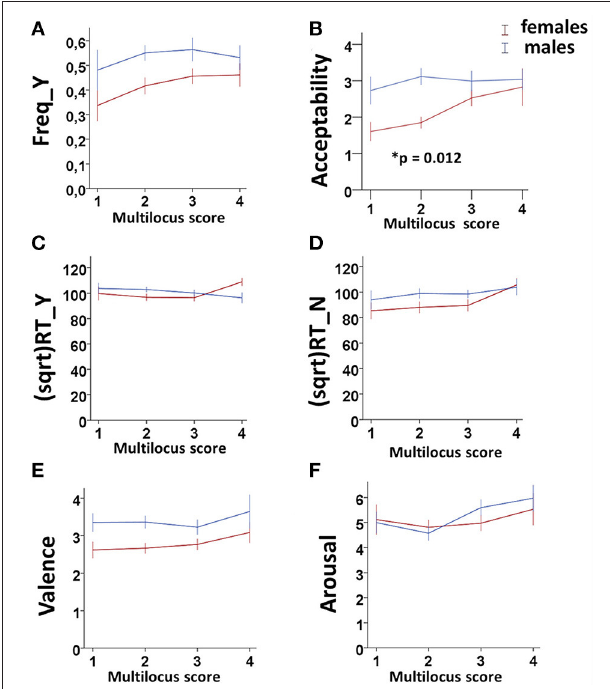
FIGURE 1 | Association results between the dopaminergic Multilocus score and Freq_Y (A) , Acceptability (B) , (sqrt)RT_Y (C) , (sqrt)RT_N (D) , Valence (E) , and Arousal (F) in the two genders . Bars represent mean ± SEM. 0.01 < * p -value ≤